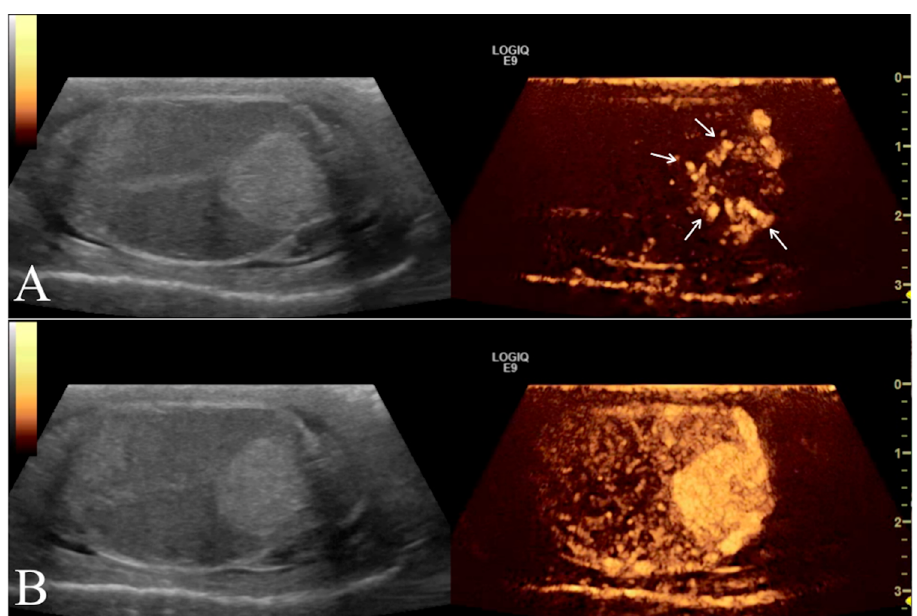
Figure 4. Left testicle leydigoma of a 11 year old Italian Mastiff (the same of Figure 2). The left panel shows the sagittal B-mode ultrasound highlighting a focal hyperechoic nodule with homogeneous echotexture and regular margin. Representative contrast-enhanced ultrasound images of different contrast distribution phases are represented in the right panels. After 16 s from contrast injection it is possible to appreciate an early distribution of the contrast within the lesions (Arrows) compared to the surrounding parenchyma ( A ). Later (25 s) the contrast medium distributes homogeneously within the lesion that remain hyperenhanced compared to the normal testicle ( B ).